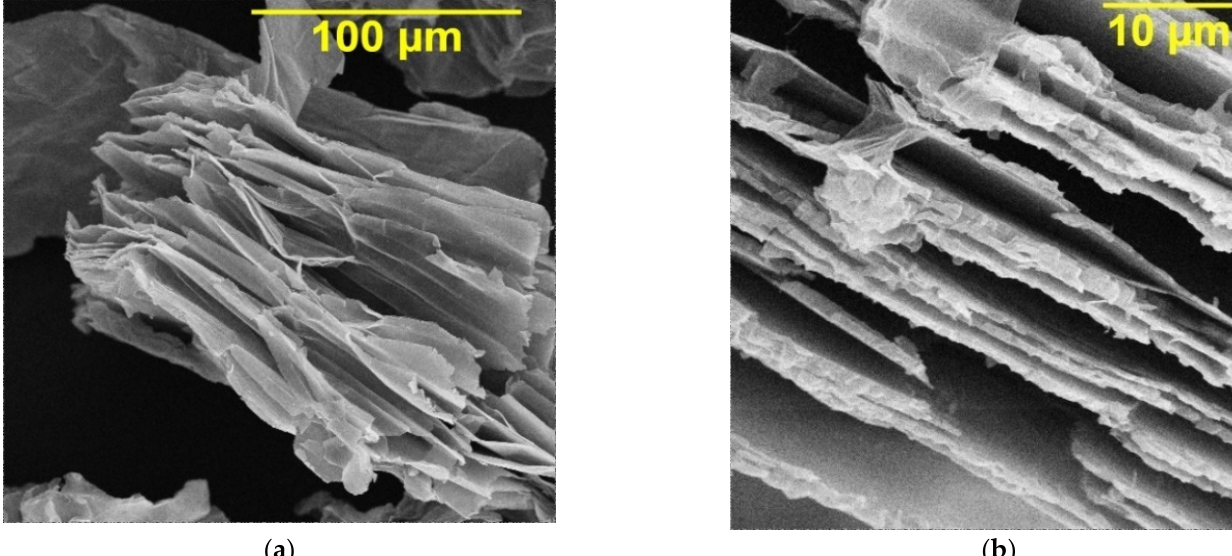
Figure 2. SEM images of the multilayer GO particles (magnifications ×1000 ( a ) and ×5000 ( b )).